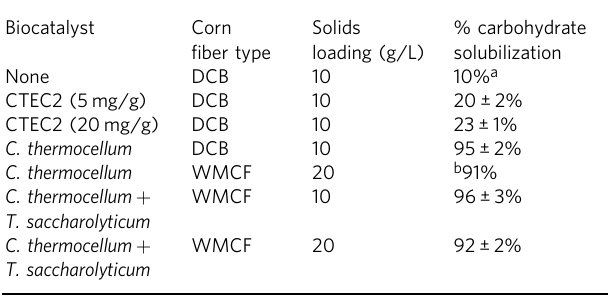
Table 1 Solubilization of corn fi ber by various